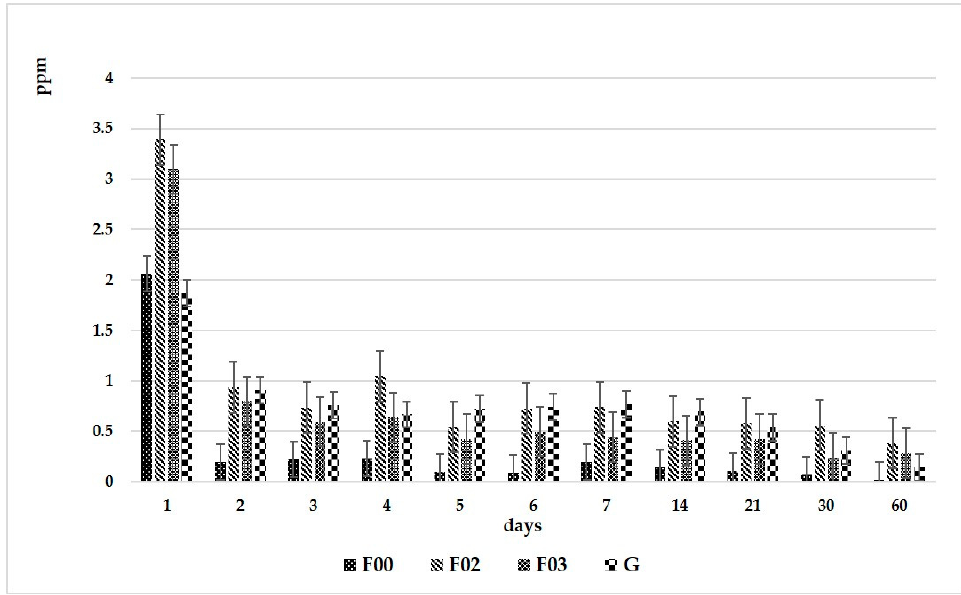
Figure 2. Daily fluoride release for the investigated materials. Mean values of fluoride release for G and B-F02 on the 7th day of the investigation are around 0.7 ppm; for B-F03, 0.44 ppm and for B-F00, 0.19 ppm. The highest mean value of fluoride release, compared to the other giomers, was registered on the 14th day, for G (0.69 ppm). The average values of fluoride released by the experimental giomer during the rest of the investigation period were: 0.54 ppm (on the 21 day), 0.30 ppm (on the 30 day) and 0.14 ppm on the 60th day. Material B-F02 released the highest fluoride mean values during days 21st, 30 and 60 (0.58 ppm, 0.55 ppm, 0.38 ppm respectively). In Figure 2 we can observe that although B-F00 released around 2 ppm fluoride during the first day, in the later days, mean values decreased (0.19 ppm on the 2nd day, 0.19 ppm day 7, 0.07 ppm day 30 and 0.01 ppm the 60th day).